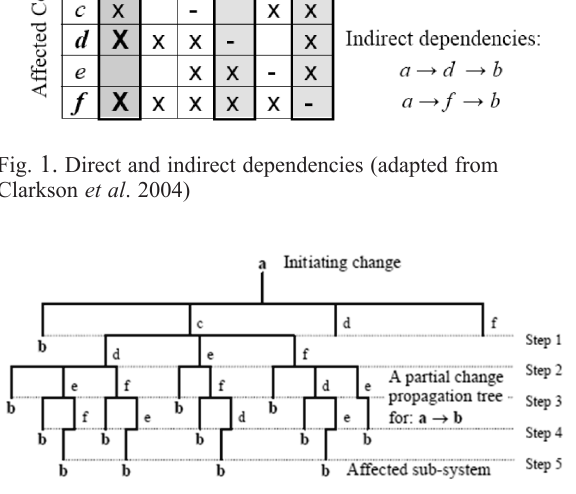
Fig. 2. A partial change propagation tree (adapted from Clarkson et al